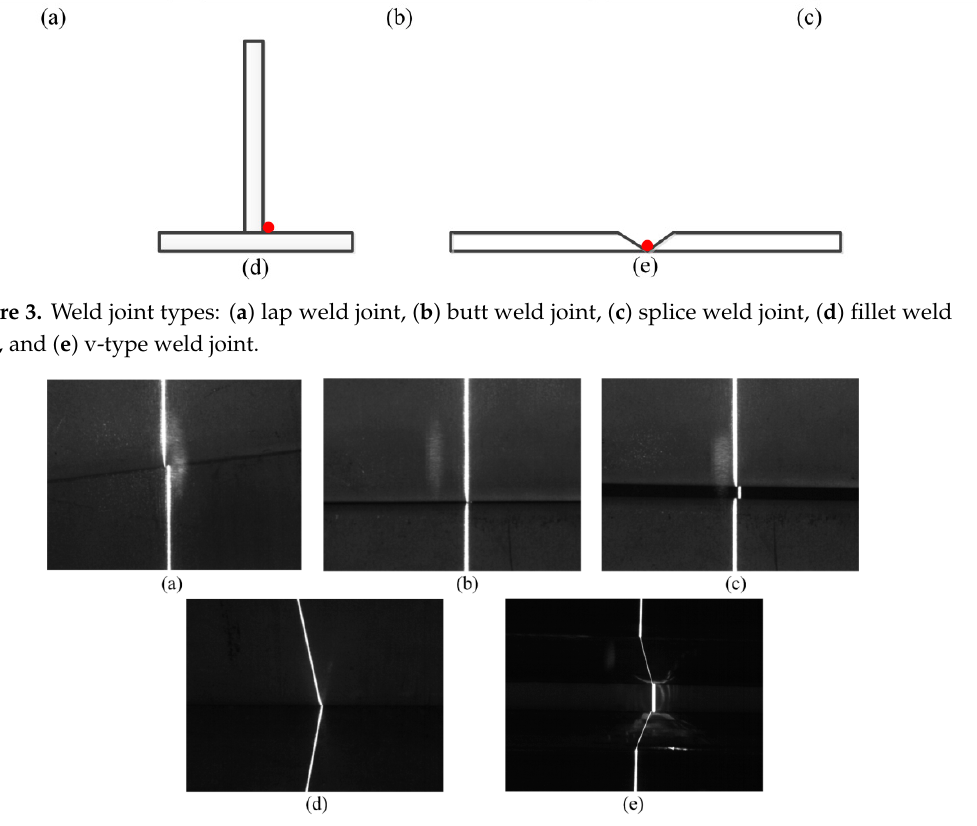
Figure 4. Weld joint images with laser stripe: ( a ) lap weld joint, ( b ) butt weld joint, ( c ) splice weld joint, ( d ) fillet weld joint, and ( e ) v-type weld joint.